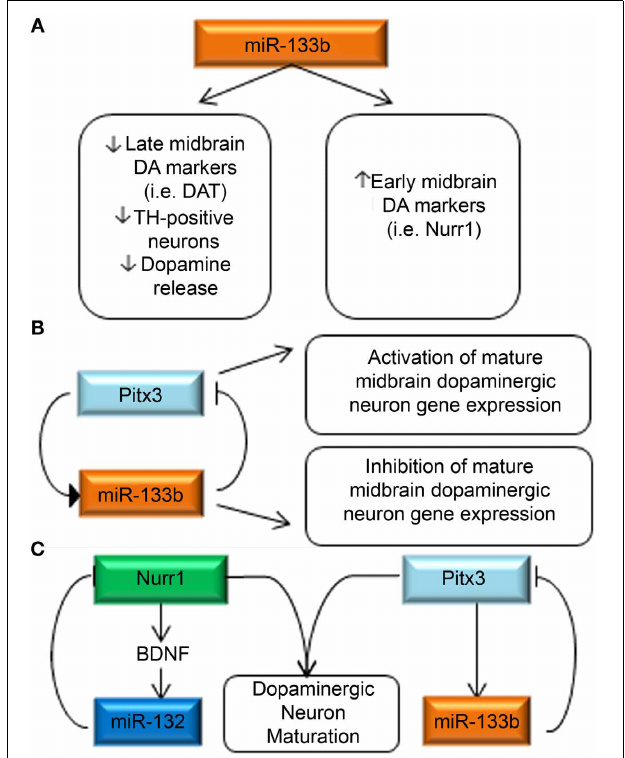
FIGURE 5 | miRNA regulation of key DA neurodevelopmental genes. (A) miR-133b decreases the expression of late DA neuron marker signatures, while increasing the expression of early DA neuron markers (Kim et al., 2007). (B) Pitx3 is capable of inducing miR-133b expression, while miR-133b is reciprocally capable of regulating Pitx3 expression. The authors hypothesize a negative feedback loop in which Pitx3 concurrently activates expression of DA maturation genes and miR-133b and when miR-133b levels reach a threshold consistent with maturation, they inhibit continued expression of Pitx3. (C) Summary of miRNA interactions with DA neuron-relevant genes. Two primary investigations have separately identified miR-132 (Yang et al., 2012) and miR-133b (Kim et al., 2007) as regulators of Nurr1 and Pitx3, respectively. It is worth noting that SNPs in both of these genes have recently been identified as potential causes of spontaneous Parkinsonism highlighting the relevance of DA neurodevelopmental events in PD